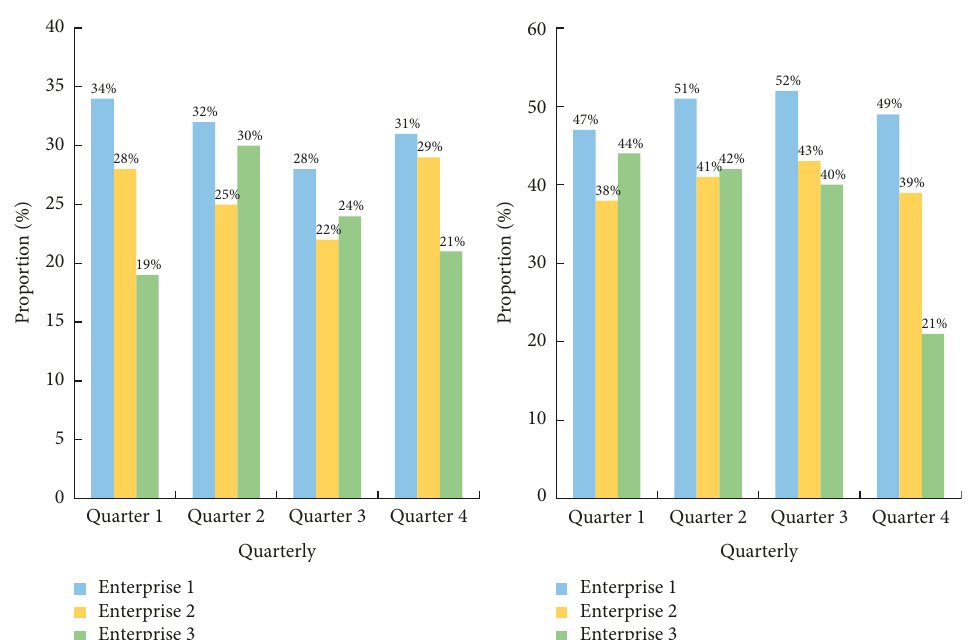
Figure 9: Transaction success rate in traditional mode and blockchain